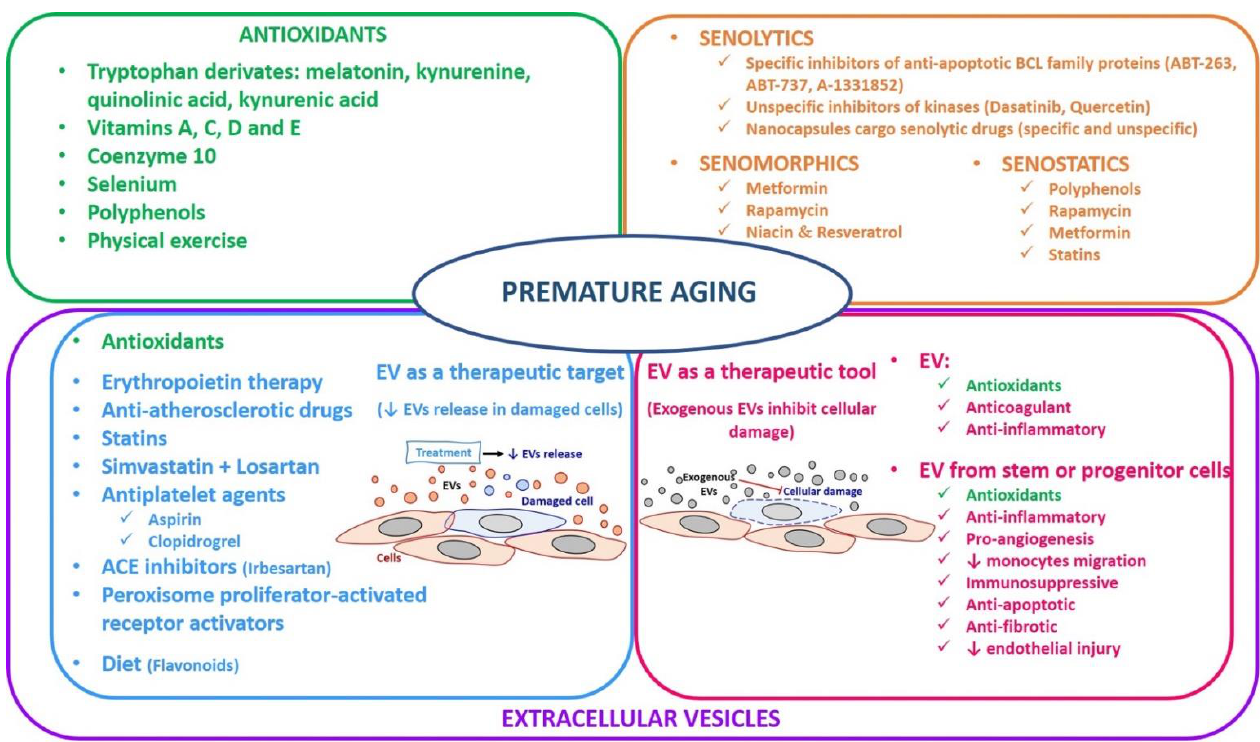
Figure 2. Therapeutical approaches in premature aging.